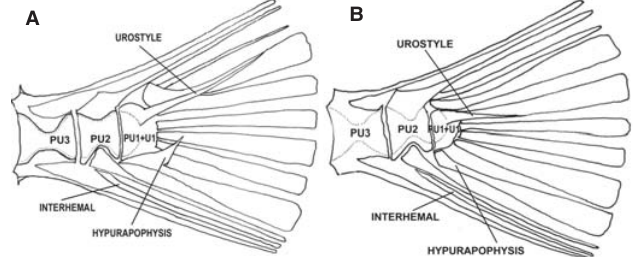
Figure 2. Caudal skeleton of a. Channa marulius (MUMF-Per/ 0025,151.6mmSL) and b. Channa gachua (MUMF-Per/0004,